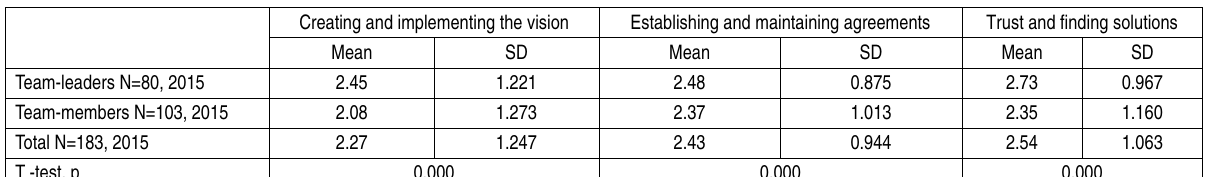
Table 3. Comparison of the characteristics of a coaching culture in the leadership style perceived by team- leaders and team-members in 2015 based on the 3C model Creating and implementing the vision